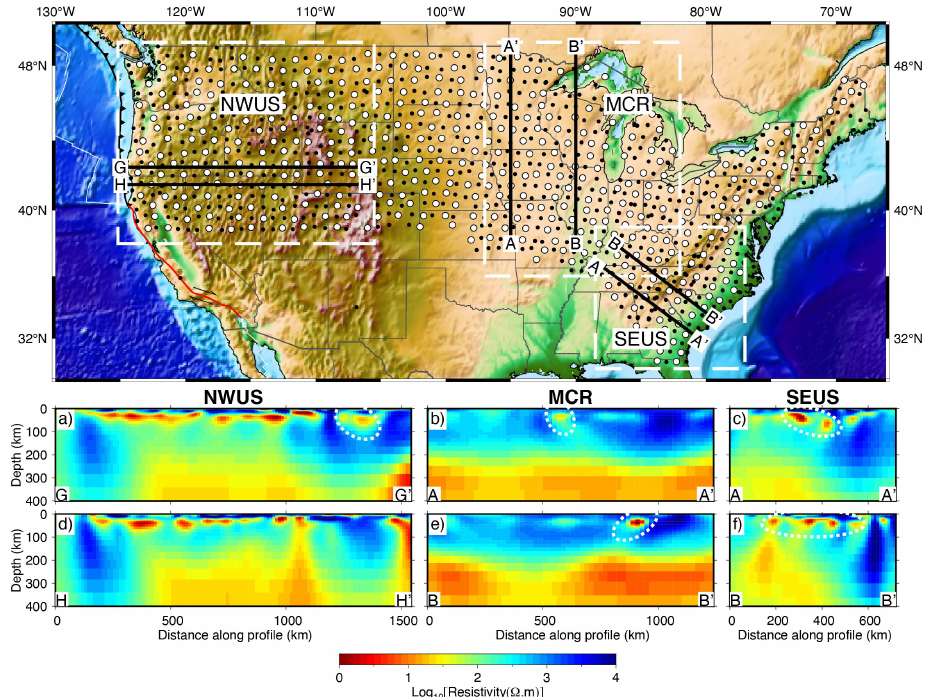
Figure 9. MT resistivity models derived from USArray MT data in the northwestern United States (NWUS) [114], the Midcontinental Rift (MCR) [94] and the southeastern United States (SEUS) [132] (modified after Yang et al. [73]). In the upper panel, the white dashed lines denote the areas of each study; black lines denote profiles discussed in these publications, labeled as in the original publications. The dots denote the MT data. ( a – f ) The areas surrounded by white dashed lines are interpreted as graphitic or sulfide-bearing metasediments that are deeply trapped along the ancient collision